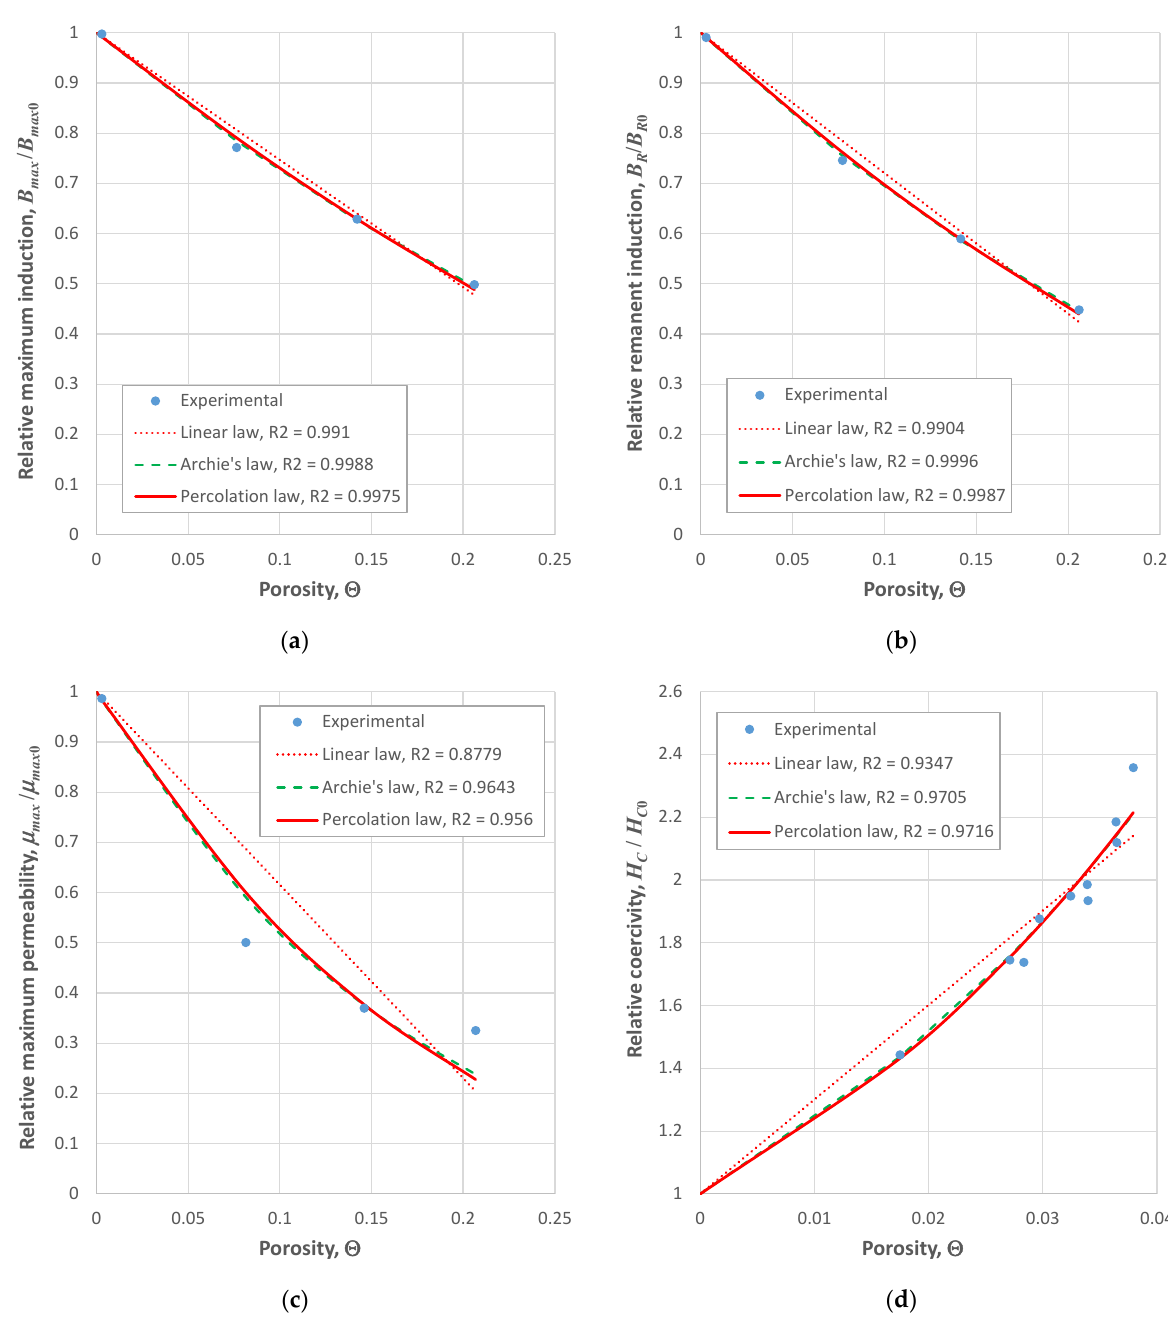
Figure 6. Experimental values of: ( a ) relative saturation induction vs. porosity [99]; ( b ) relative remanent induction vs. porosity [99]; ( c ) relative maximum permeability vs. porosity [99]; ( d ) relative coercivity vs. porosity [94], and fitting with the linear law, Archie’s law and the percolation